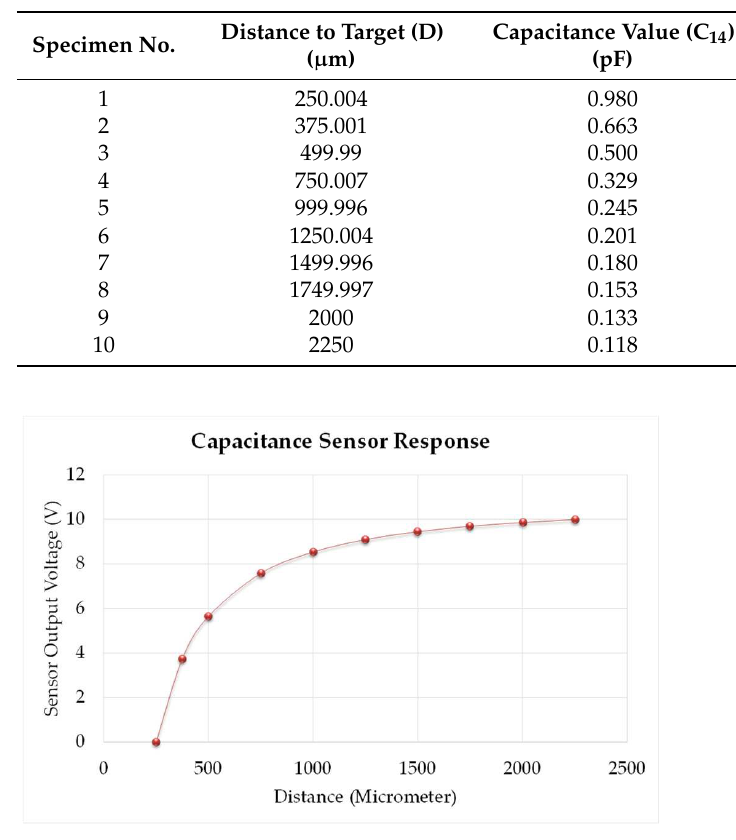
Table 3. Experiment on calibration of sensor against selected specimens to obtain estimation model.